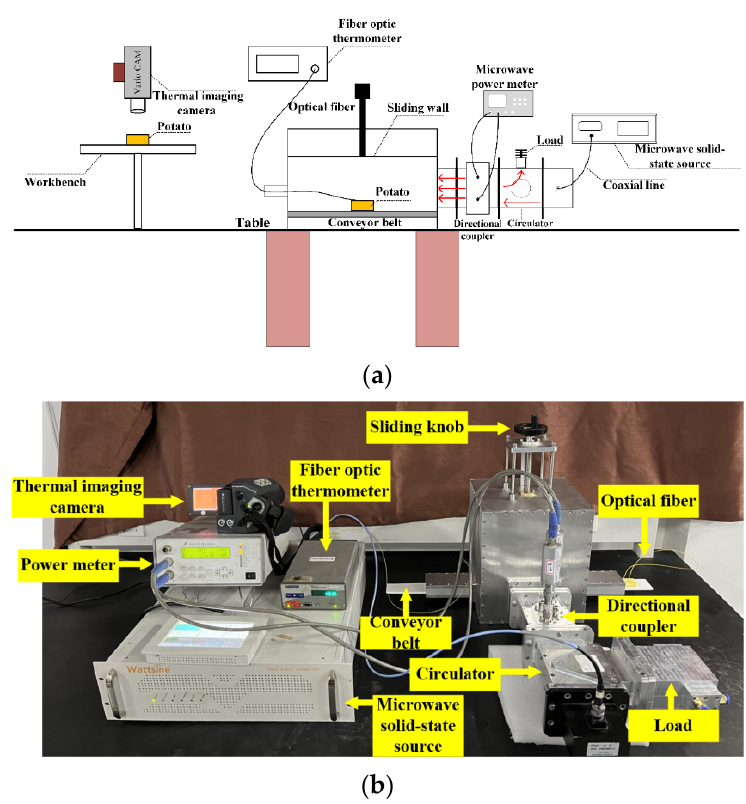
Figure 9. ( a ) Sketch of the experimental system; ( b ) actual experimental system.